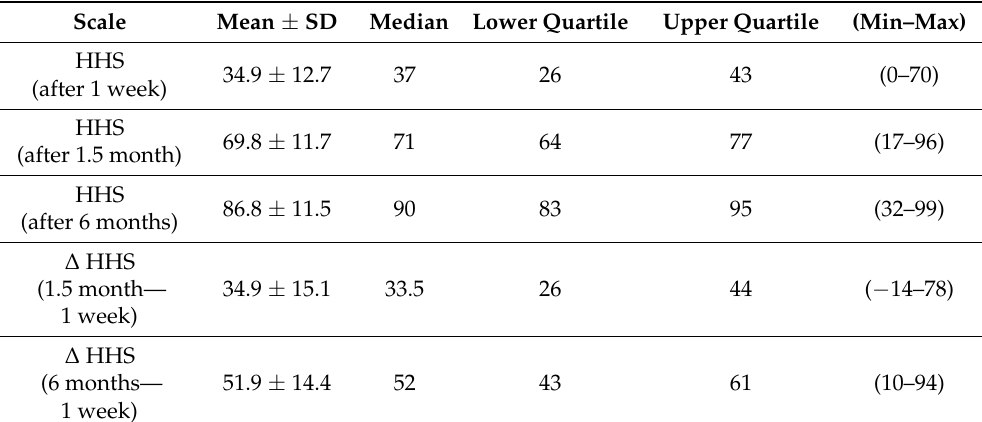
Table 2. Evaluation of patients‘ hip function after hip arthroplasty at defined